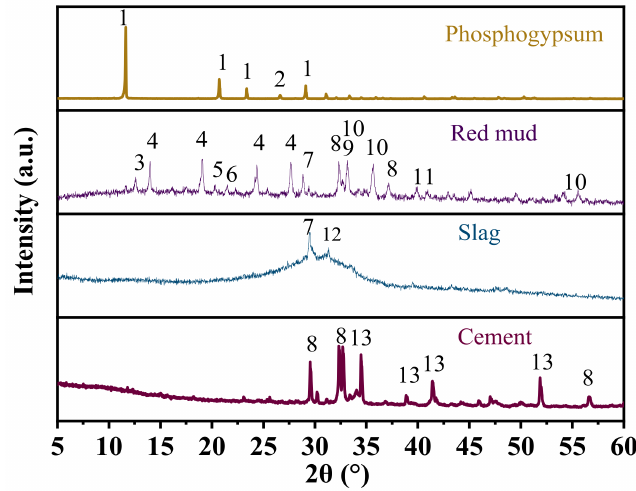
Figure 1. XRD patterns of main materials (1: calcium sulfate dihydrate; 2: quartz; 3: sodium zeolite;